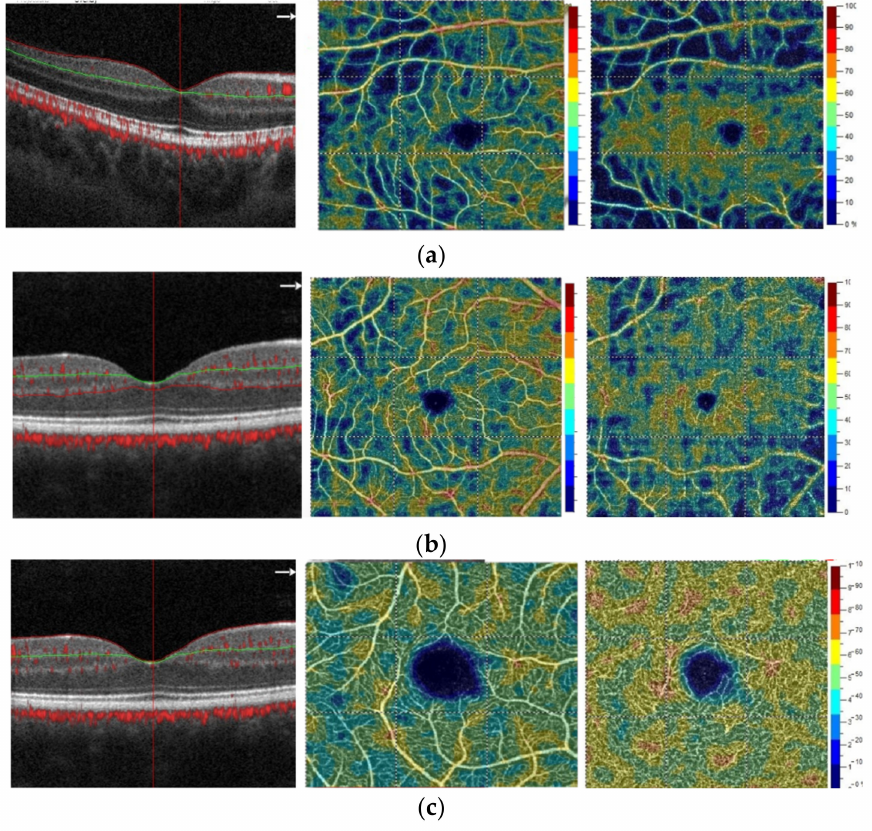
Figure 2. OCTA of the macular vessel density—B-scan, superficial vascular complex, deep vascular